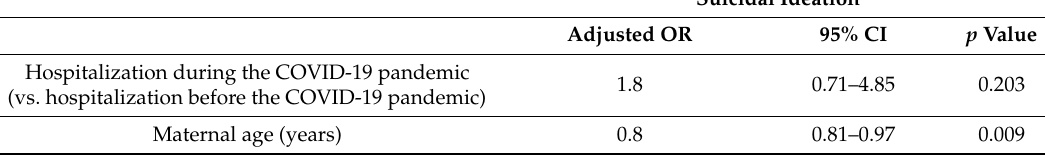
Model 1 EDPS Score >